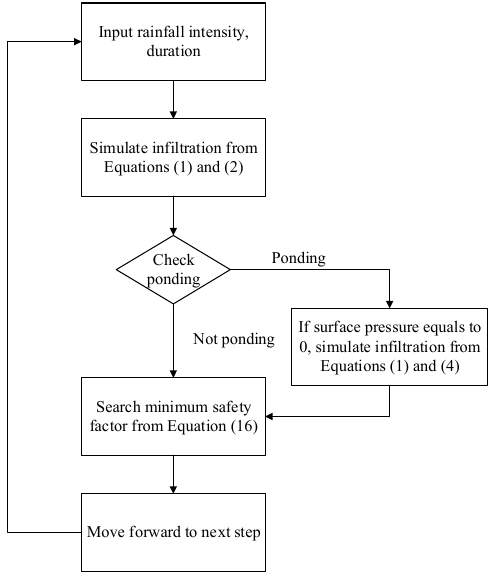
Figure 2. Flow chart for computational procedure.